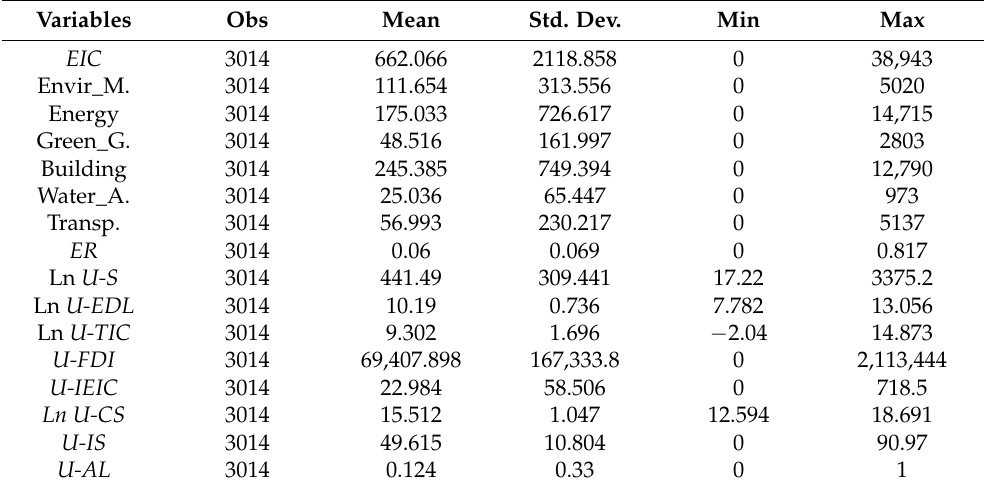
Table 6. Descriptive statistics of China city panel data and six types of environment-related technologies.